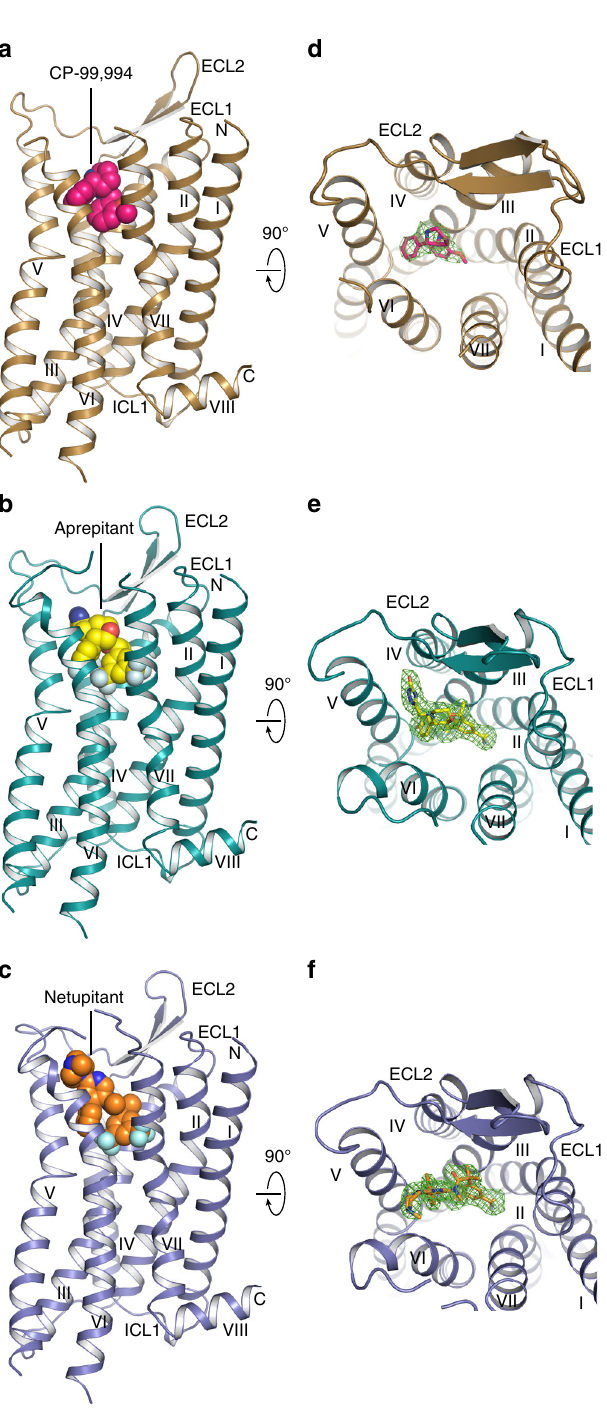
Fig. 1 Overall structures of antagonist-bound NK 1 R. a – c NK 1 R in complex with CP-99,994 ( a ), aprepitant ( b ) and netupitant ( c ), viewed parallel to the membrane plane. The receptors are depicted by ribbons and coloured in brown, turquois and blue, respectively. The ligands CP-99,994, aprepitant and netupitant are shown as spheres and coloured in pink, yellow and orange, respectively. Oxygen, nitrogen and fl uorine atoms of the ligands are highlighted in red, blue and grey, respectively. d – f NK 1 R in complex with CP-99,994 ( d ), aprepitant ( e ) and netupitant ( f ), viewed from the extracellular space and coloured as in ( a – c ). The ligands are depicted as sticks. 2F o -F c electron density maps of the ligands are shown in green mesh contoured at 1.0